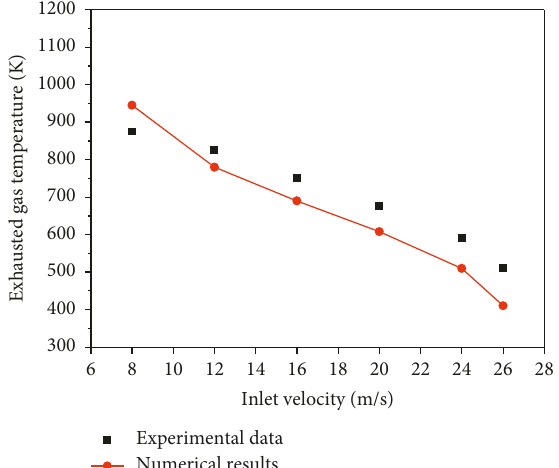
Figure 4: Comparison between experimental data and numerical results for exhaust gas temperature in the original